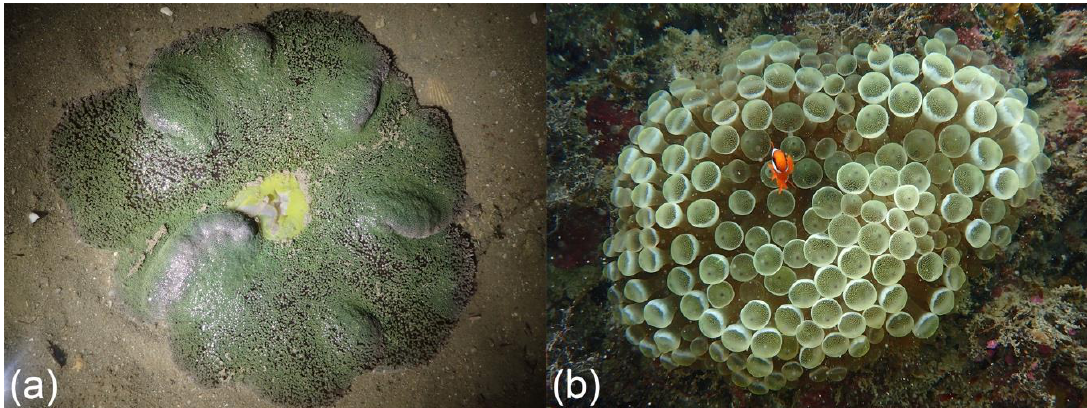
Figure 1. ( a ) Stichodactyla haddoni and ( b ) Entacmaea quadricolor .